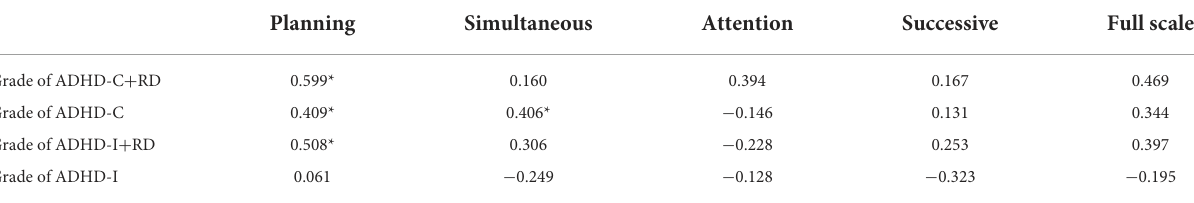
TABLE 4 Correlations between grade and the Das-Naglieri Cognitive Assessment System sub-scale